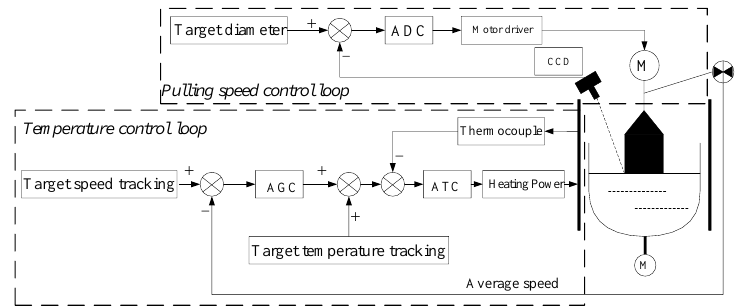
Figure 1. Schematic diagram of the control system for Czochralski silicon single-crystal growth. The frequent change in the pulling speed will cause some defects in the crystal. In this control structure, it is ensured that the system can respond quickly to the perturbations of the crystal diameter. The model between the pulling speed and the crystal diameter is characterized by the time delay and nonlinearity, which are challenging to deal